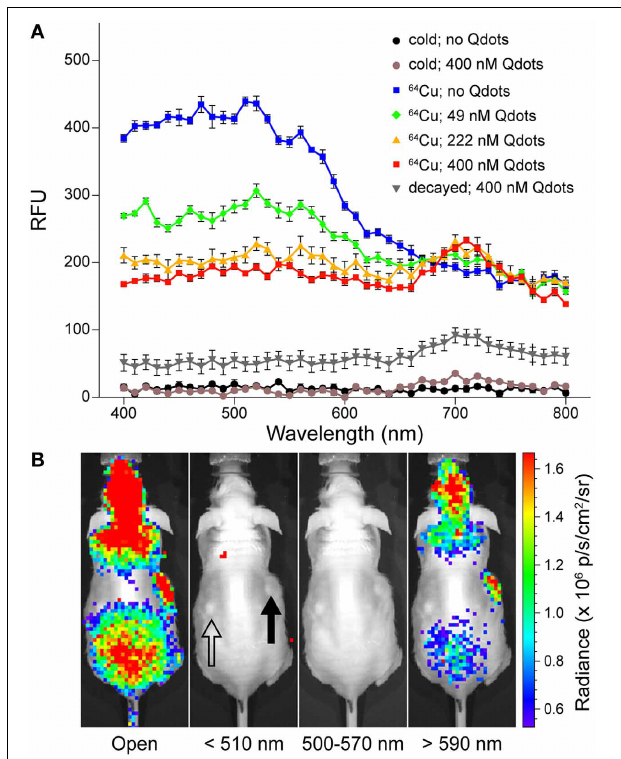
FIGURE 4 | (A) UV/vis emission spectra of [ 64 Cu]CuCl 2 in PBS containing various concentrations of Qtracker705 nanoparticles (Qdots), [ 64 Cu]CuCl 2 without Qdots (blue), [ 64 Cu]CuCl 2 with 49nM (green), 222nM (orange), 400nM Qdots(red); non-radioactive CuCl 2 without Qdots (black), with 400nM Qdots(brown); and decayed [ 64 Cu]CuCl 2 with 400nM Qdots (gray). (B) In vivo CRET imaging of subcutaneous pseudotumors of 500nM Qdots with Matrigel (closed arrow) and PBS with Matrigel (open arrow) in opposing flanks of nu/nu mice by using IVIS 100 with open, 510nm (blue band), 500–570nm (green band), and 590nm (red band) filters following tail-vein injection of 18 F-FDG (17.6MBq). (Adapted with the permission of Dothager et al.